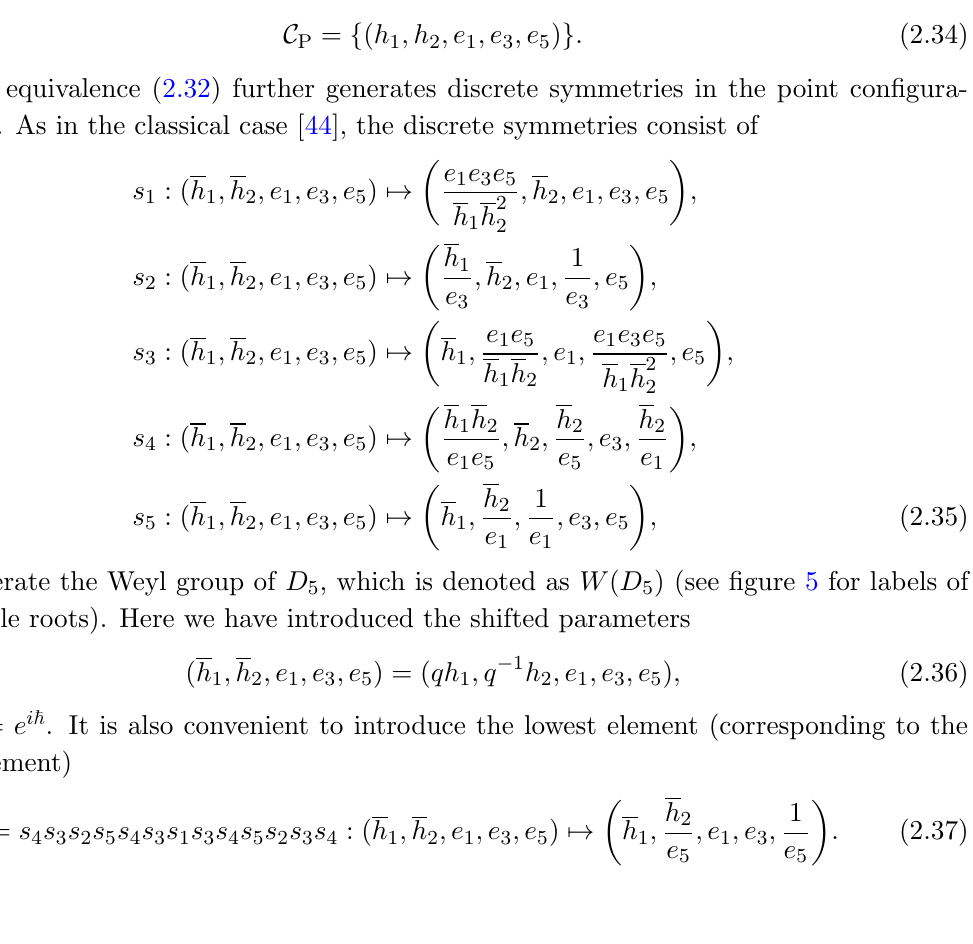
; e (cid:0) 1 g , f e 3 ; e 4 g , f h (cid:0) 1 e 5 ; h (cid:0) 1 e 6 g and f h 1 e (cid:0) 1 ; h 1 e (cid:0) 1 g . We omit the minus 1 2 2 2 7 8